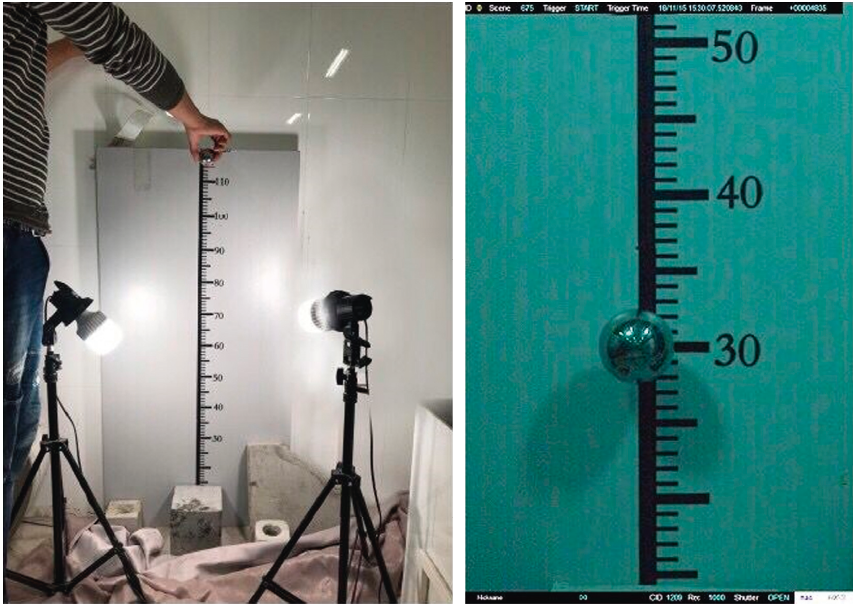
Figure 4: Rebound test and rebound height